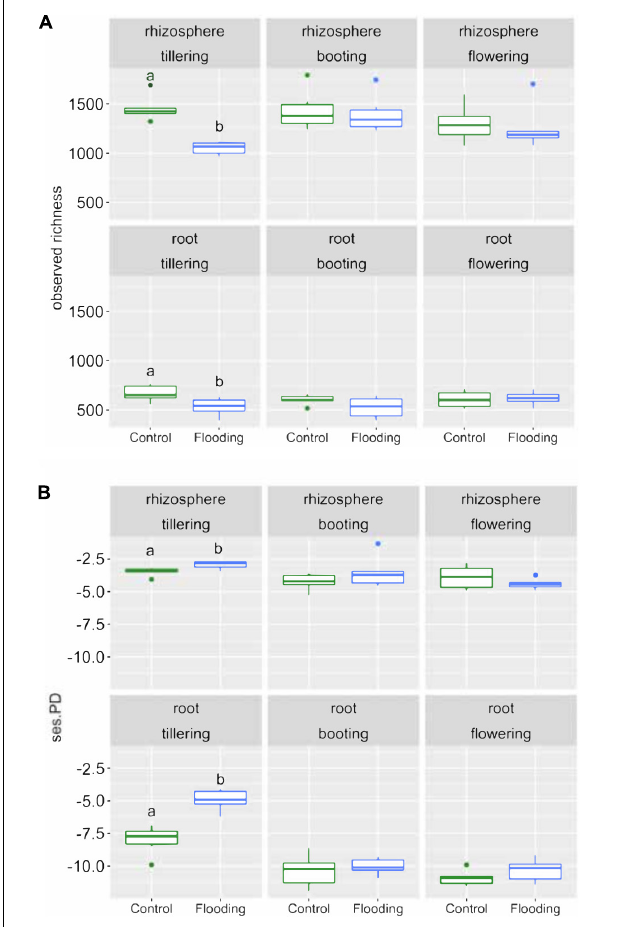
FIGURE 1 | Box plots of the observed richness (A) and standardize effect size of phylogenetic diversity (ses.PD) (B) of the bacterial communities in the samples studied. Different letters indicate significant differences between water treatments within the same PGS based on Tukey’s HSD test p < 0.05.